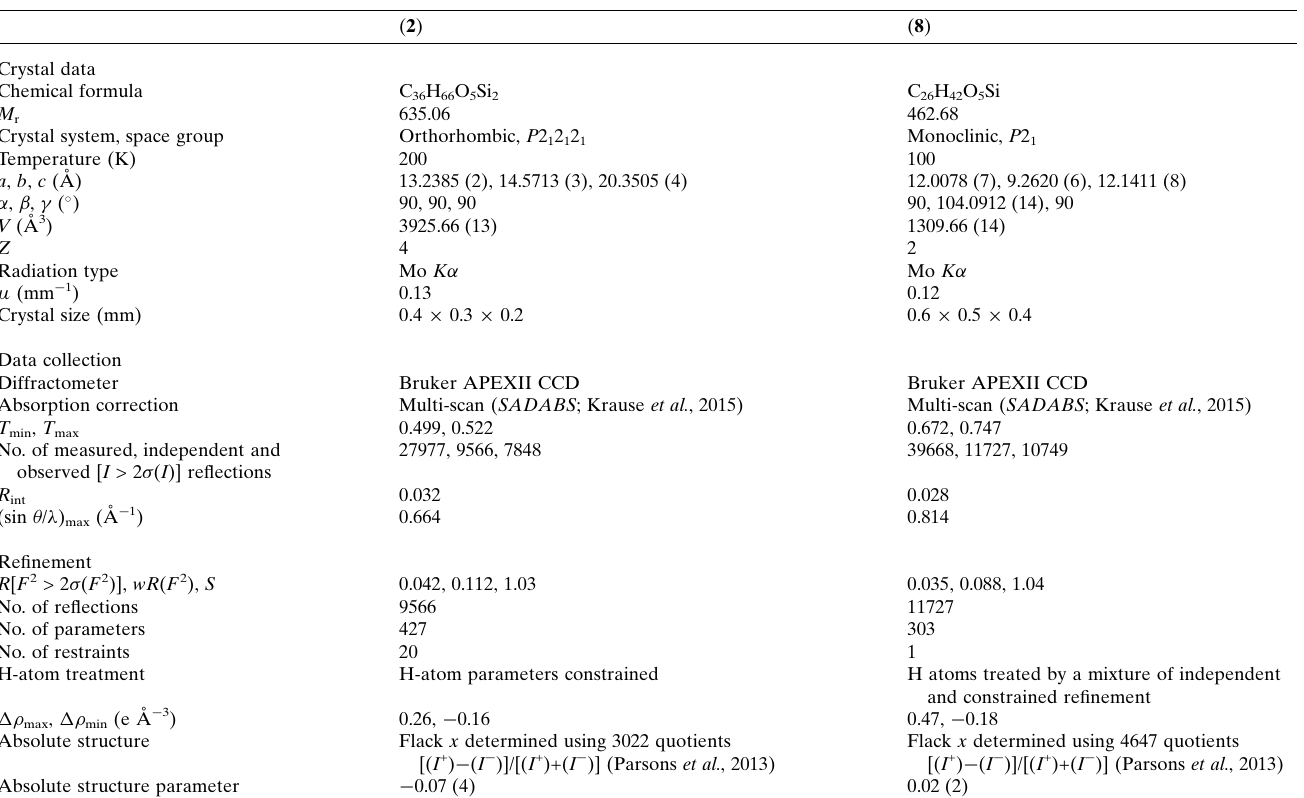
Table 3 Experimental details.